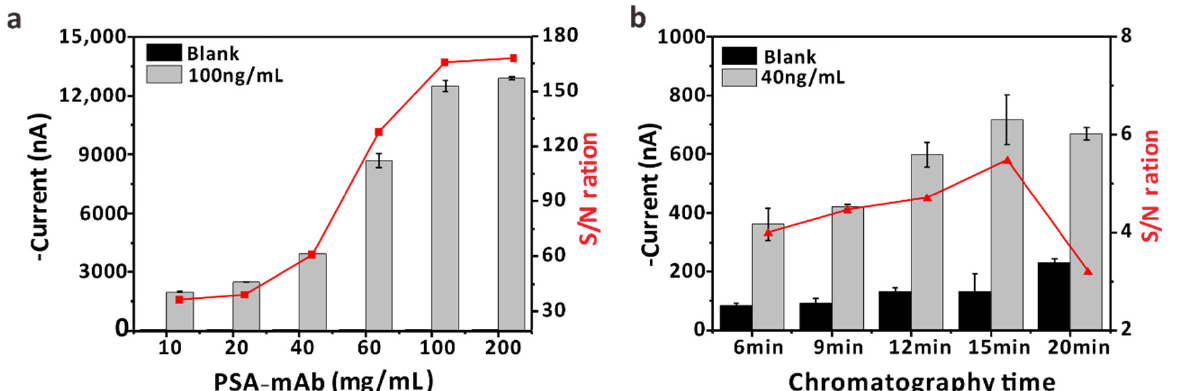
Figure 2. ( a ) Optimization of the coating concentration of the PSA capture antibody. ( b ) Optimization of the chromatographic reaction time of the EIC system for PSA detection.